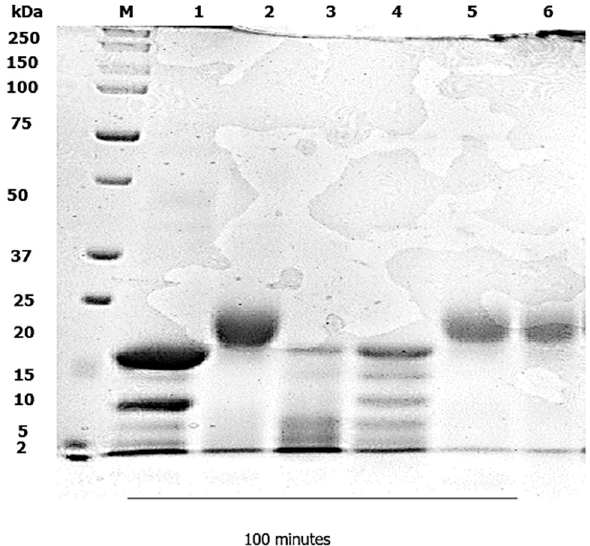
Figure 3. In vitro infant static duodenal digestion model of native WPI using pancreatin or without pancreatin: Lane 1 represents WPI without pancreatin; Lane 2 represents 0 min; Lane 3 represents 5 min; Lane 4 represents 30 min; Lane 5 represents 60 min; and Lane 6 represents 100 min. Lane M represents the protein marker.